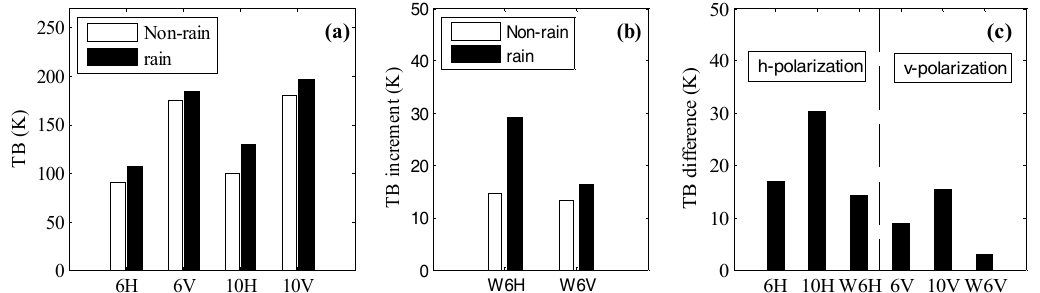
Figure 11. Comparison of radiance characteristics for rain area and non-rain area over hurricane Bill on 21 August 2009, at 0555 to 0559 UTC. ( a ) Average brightness temperature of each selected channel; ( b ) average brightness temperature increment of W6H (W6V); and ( c ) brightness temperature difference caused by rain.